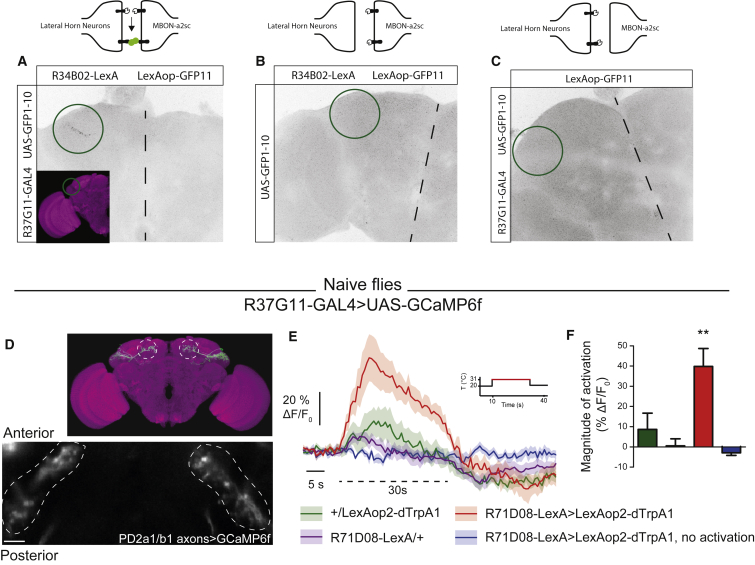
MBON-ɑ2sc Is Functionally Connected to PD2a1 and PD2b1(A–C) GRASP signal in the dorsal LH (green circles, dashed lines indicate midlines) for the experimental genotype (A) and two controls (B and C). Genotypes and controls are represented in the schematics above each figure. Images are representative of n = 3.(D) GCaMP6f was expressed in PD2a1 and PD2b1 neurons with the R37G11-GAL4 driver (scale bar, 10 μm). Fluorescence was recorded in vivo from the axonal compartment of PD2a1 and PD2b1 neurons while the temperature was shifted from 20°C to 31°C (dashed line on F, except for the blue trace).(E) The calcium increase of PD2a1 and PD2b1 neurons because of thermal activation of V2 MBONs (red trace) was stronger than that because of temperature shift only in the genotypic controls (green and purple traces).(F) Quantification of calcium increase from the traces (n = 10 flies per condition, except 71D08-LexA/+ [n = 8], F(3,37) = 9.09, p = 0.0001).∗∗p < 0.01. Data are presented as mean ± SEM. See also Figure S6.